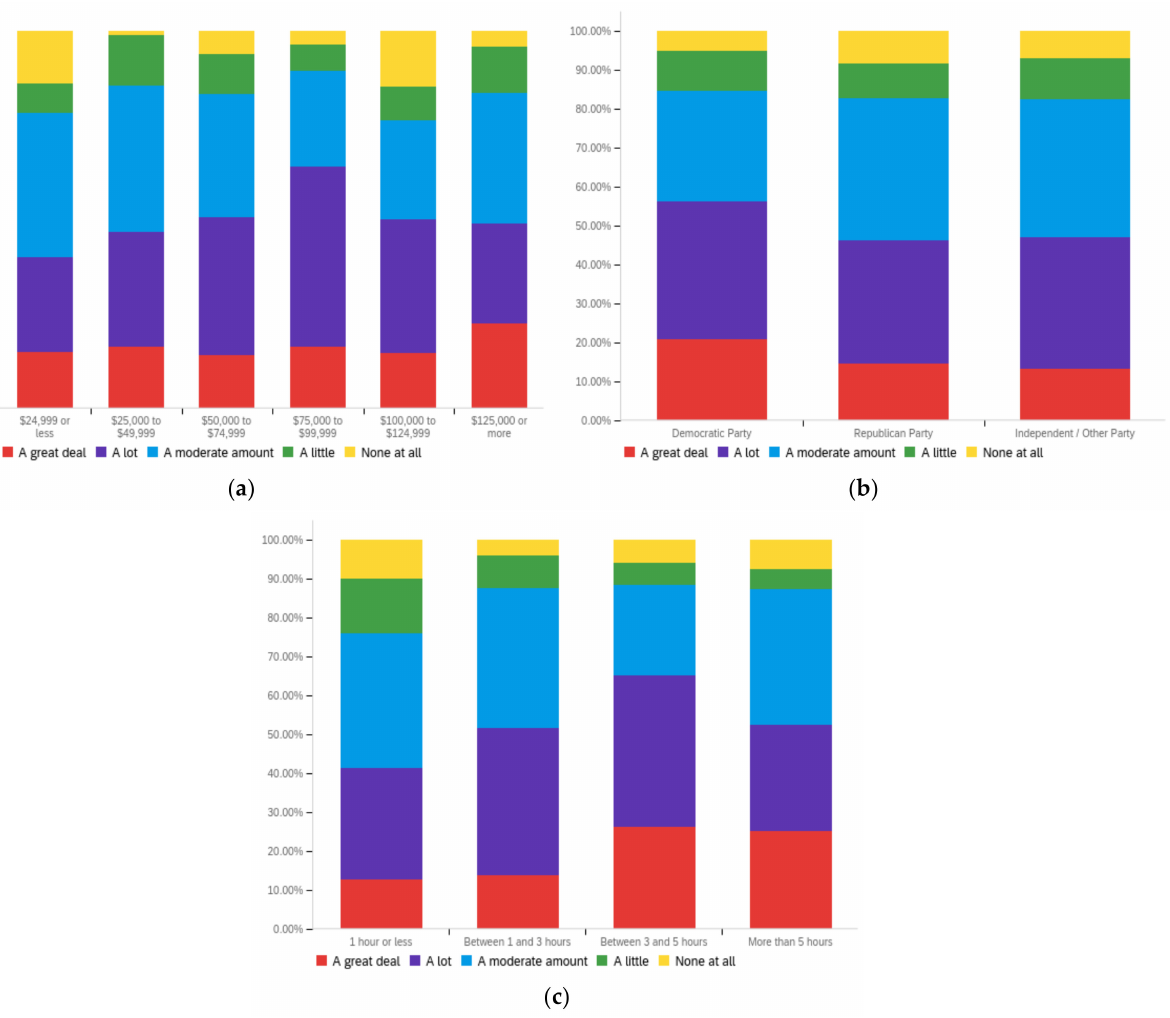
Figure A4. Article publisher—personal perception impact by: ( a ) income level (top left), ( b ) political affiliation (top right) and ( c ) online usage (bottom).